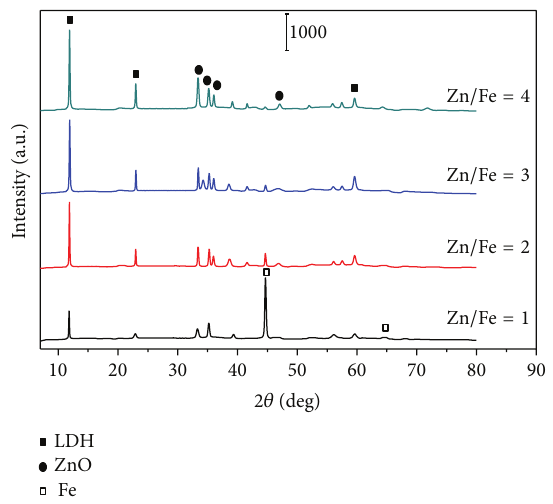
Figure 1: PXRD patterns of Zn-Fe-LDH samples synthesized at different Zn 2+ /Fe 3+ molar